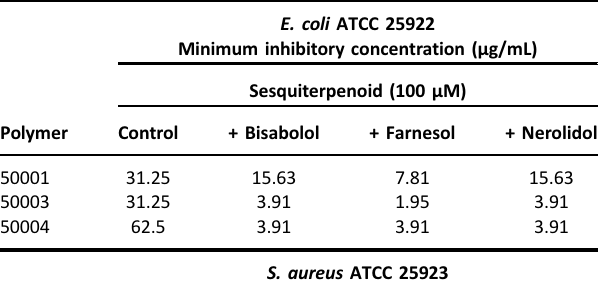
Table 1. Minimum inhibitory concentrations of PMX polymers and enhancement by sesquiterpenoids against select microorganisms.